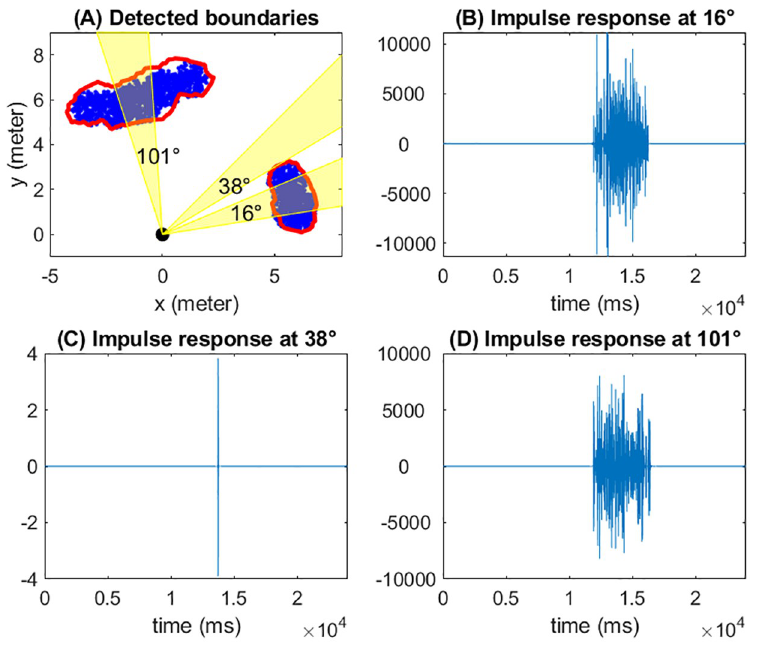
Fig 5. Boundary detection. (A) An overlooking view of two isolated clusters of foliage, together with their detected boundaries. For both emission and reception, the beampattern peak amplitude is set to 40 dB, and the beamwidth is set to 5˚. Tree leaves are shown in blue dots, and the detected boundaries are shown in red lines. Sonar beams at three azimuth angles 16˚, 38˚, and 101˚are shown in yellow color. (B,C,D) The corresponding echo waveforms at 16˚, 38˚, and